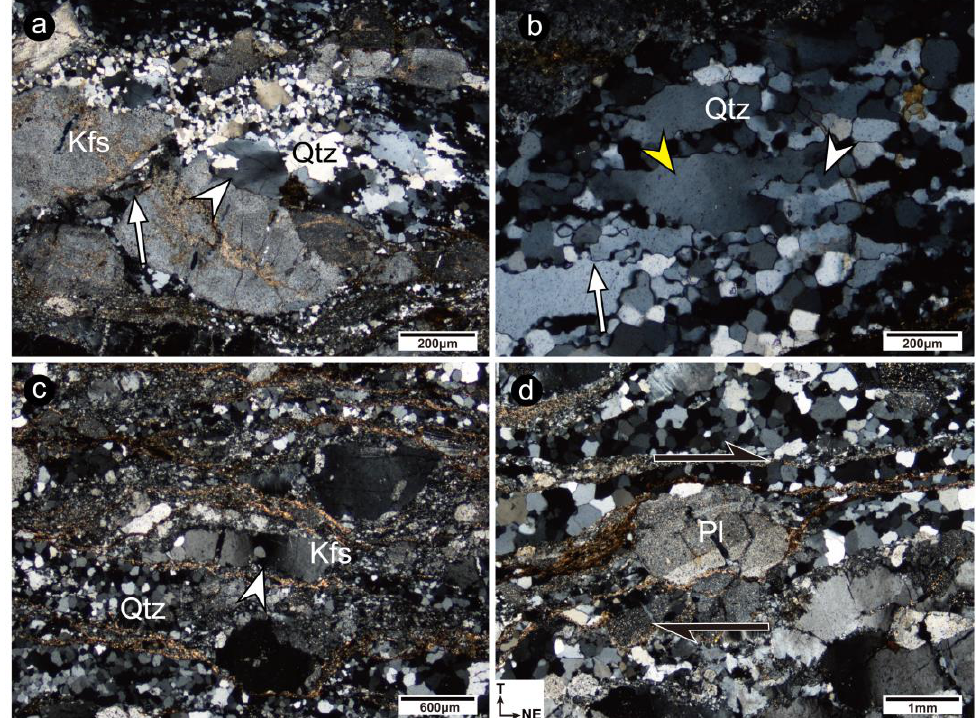
Figure 7. Photomicrographs (cross-polarized light) showing microstructures of the Deokjeok Shear Zone (DSZ). ( a ) Deformation band in quartz (arrow) and intragranular fractures in K-feldspar (long arrow). ( b ) Recrystallized quartz grains through bulging (long arrow) and subgrain rotation (arrow), and patchy undulatory extinction in original quartz grain (yellow arrow). ( c ) Deformation band in K-feldspar. ( d ) σ-type strain shadow indicating top-down-to-the-northeast sense of shear. Abbreviations: Qtz—Quartz, Kfs—K-feldspar, Pl—Plagioclase.